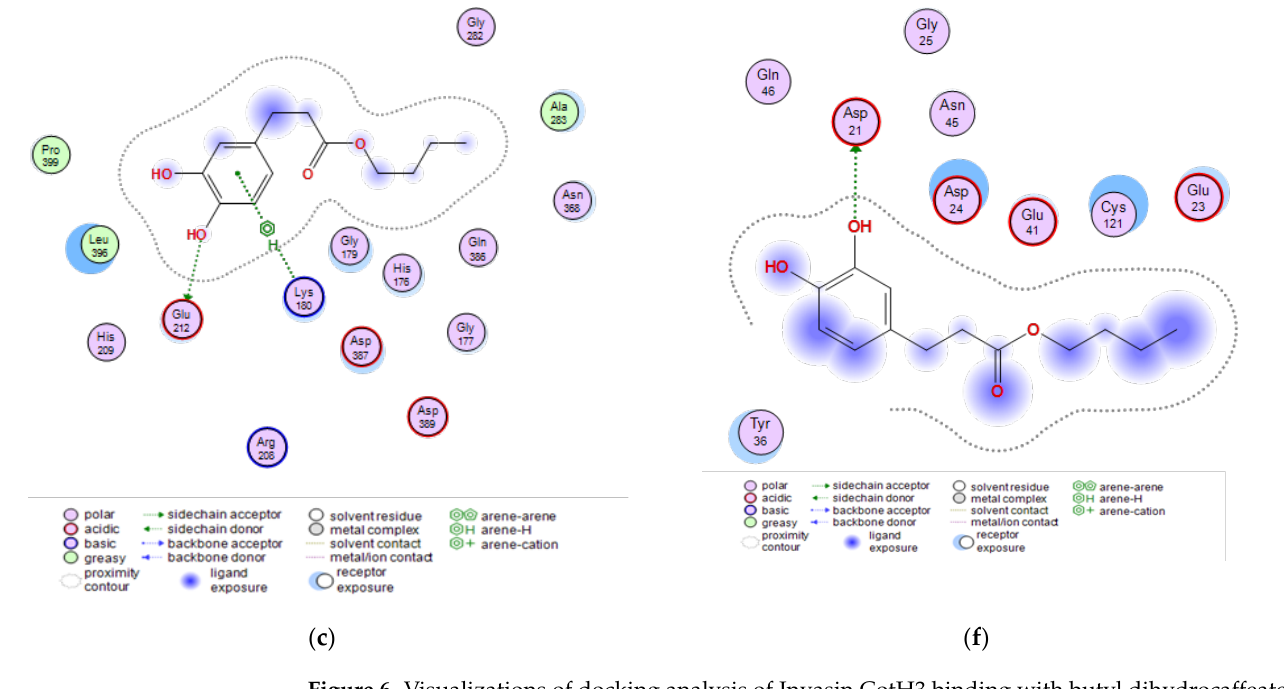
Figure 6. Visualizations of docking analysis of Invasin CotH3 binding with butyl dihydrocaffeate: ( a , b ) 3D visualizations, ( c ) 2D binding interactions, and Mucoricin binding with butyl dihydrocaffeate: ( d , e ) 3D visualizations, ( f ) 2D binding interactions. Table 4. Molecular docking scores of the query ligands docked to target proteins (glutamine-fructose-6-phosphate transaminase (GFAT), 14- α sterol demethylase B, Invasin CotH3, and Mucoricin).